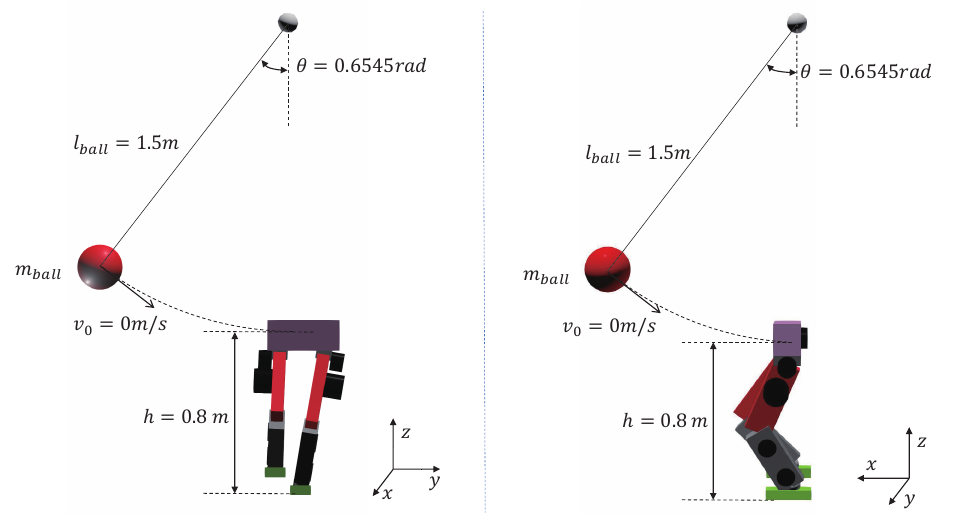
Figure 3. Schematic diagram of collision